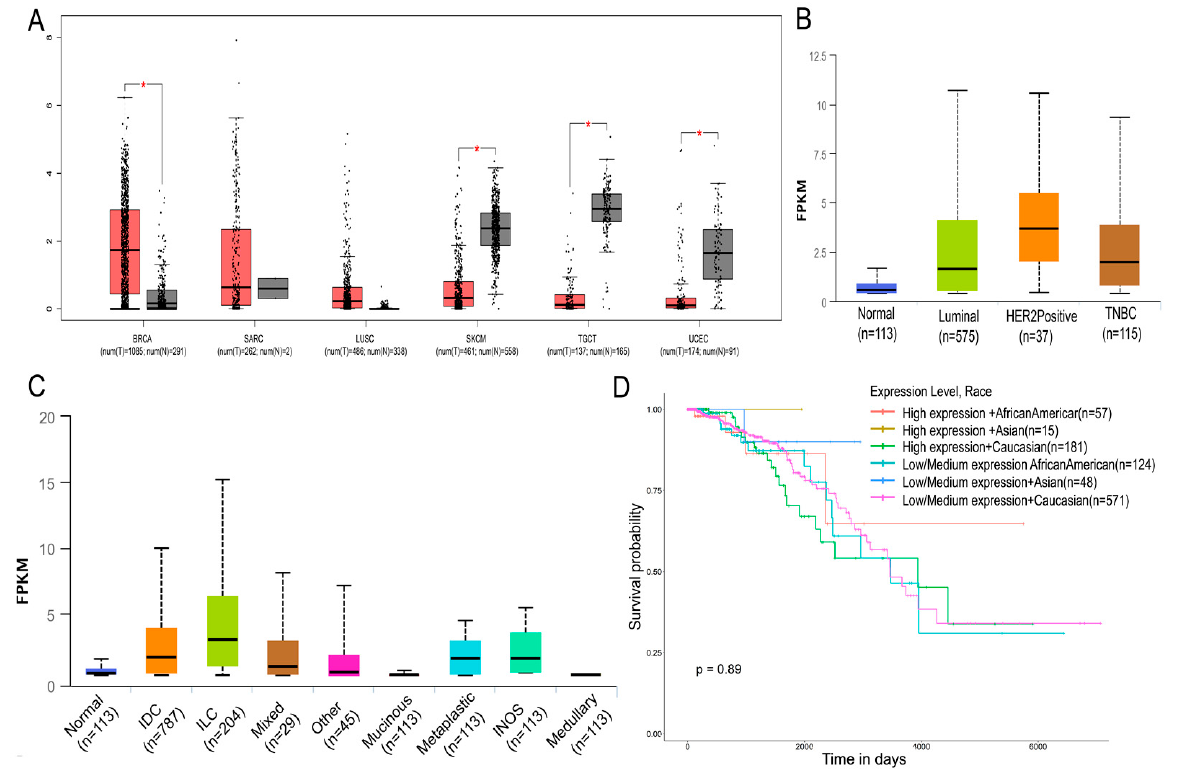
Figure 1. HOTAIR is highly expressed in breast cancer. Data analysis from GEPIA and UALCAN. ( A ) Among various cancers, HOTAIR was significantly overexpressed in breast cancer. ( B ) HOTAIR was significantly overexpressed in luminal breast cancer, HER2 -positive breast cancer, and TNBC. ( C ) Compared with normal tissues, HOTAIR was significantly overexpressed in breast invasive carcinoma. ( D ) Breast cancer patients with high expression of HOTAIR might have a poorer prognosis. BRCA, breast invasive carcinoma; LUSC, lung squamous cell carcinoma; SARC, sarcoma; SKCM, skin cutaneous melanoma; TGCT, testicular germ cell tumors; TNBC, triple-negative breast cancer; UCEC, uterine corpus endometrial carcinoma; IDC, invasive ductal carcinoma; ILC, invasive lobular carcinoma; TNBC, triple-negative breast cancer. Values were significantly different compared with the corresponding control value at * p < 0.05.